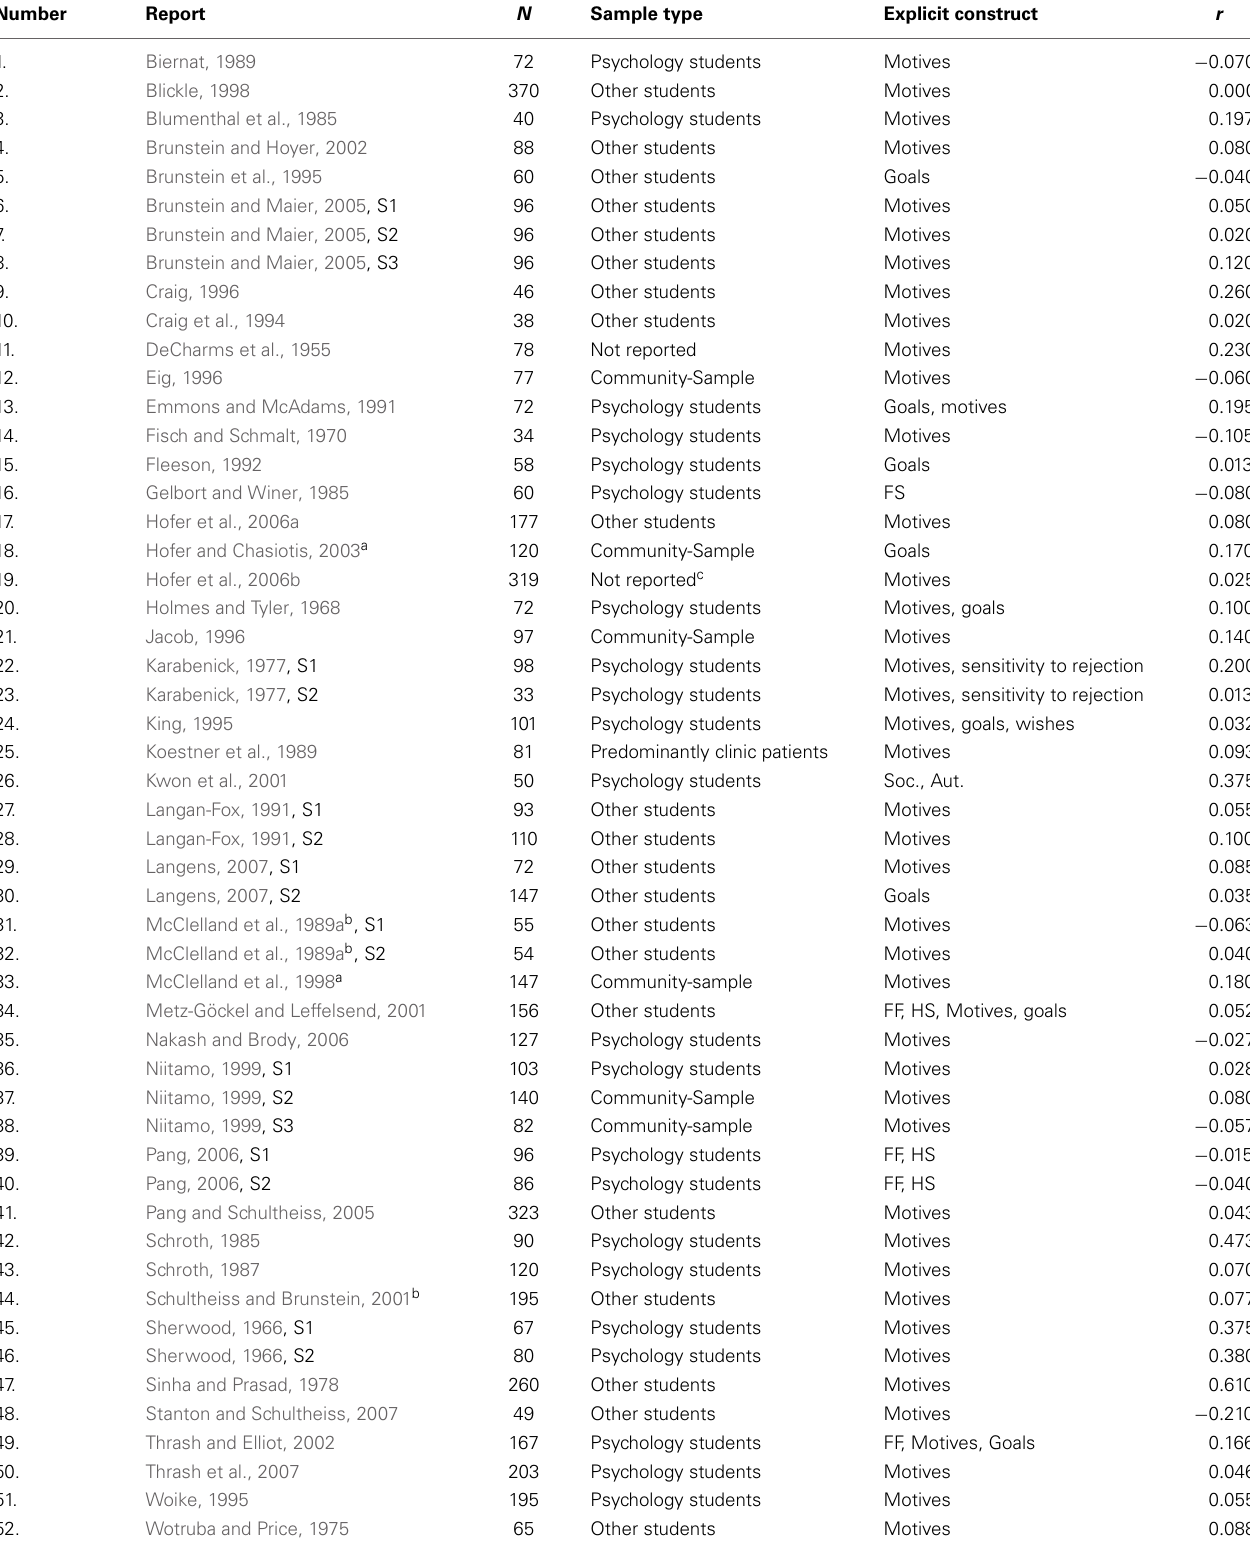
Table 3 | Overview over accepted studies including sample size and sample type, explicit constructs and study